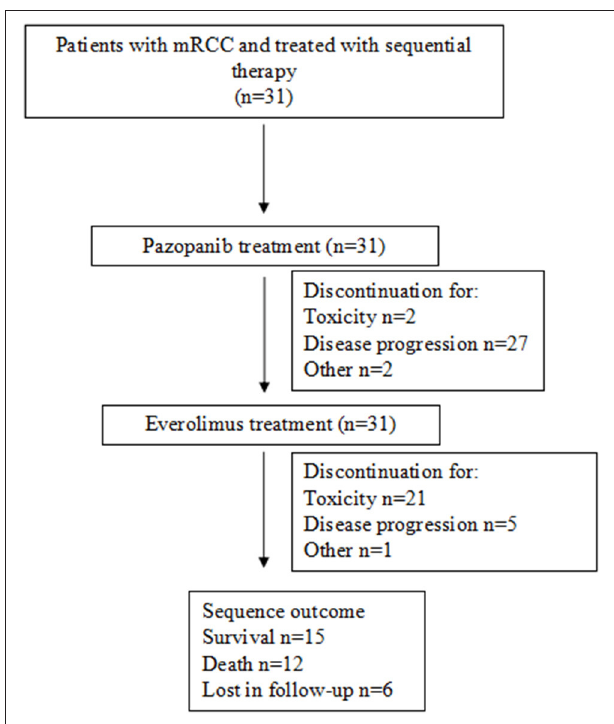
FIGURE 1 | Study overview.